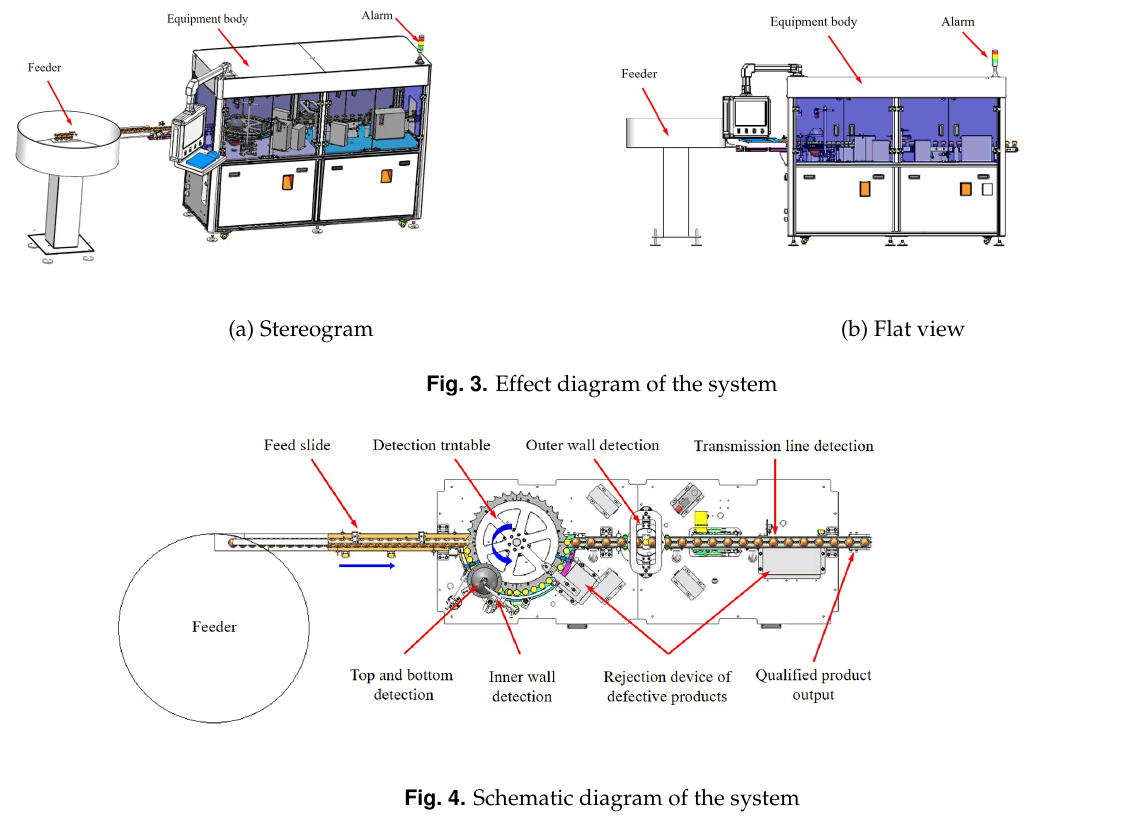
Fig. 4. Schematic diagram of the